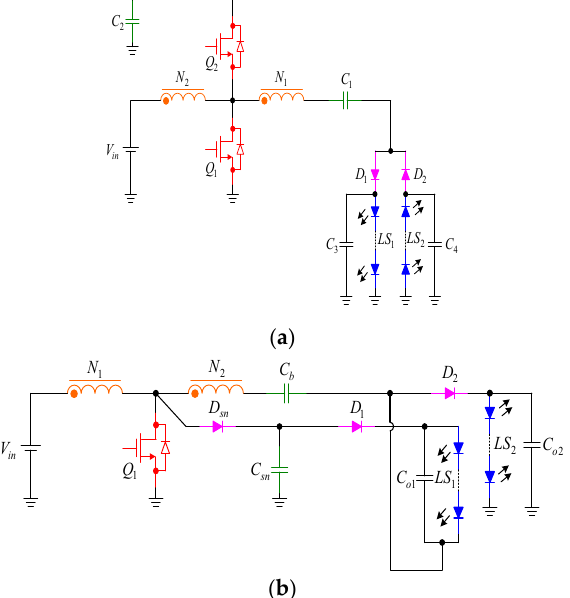
Figure 1. Prior work: ( a ) non-isolated two channel LED driver with automatic current balance and zero voltage switching [14]; ( b ) non-isolated single-switch two-channel LED driver with passive regenerative snubber [15].